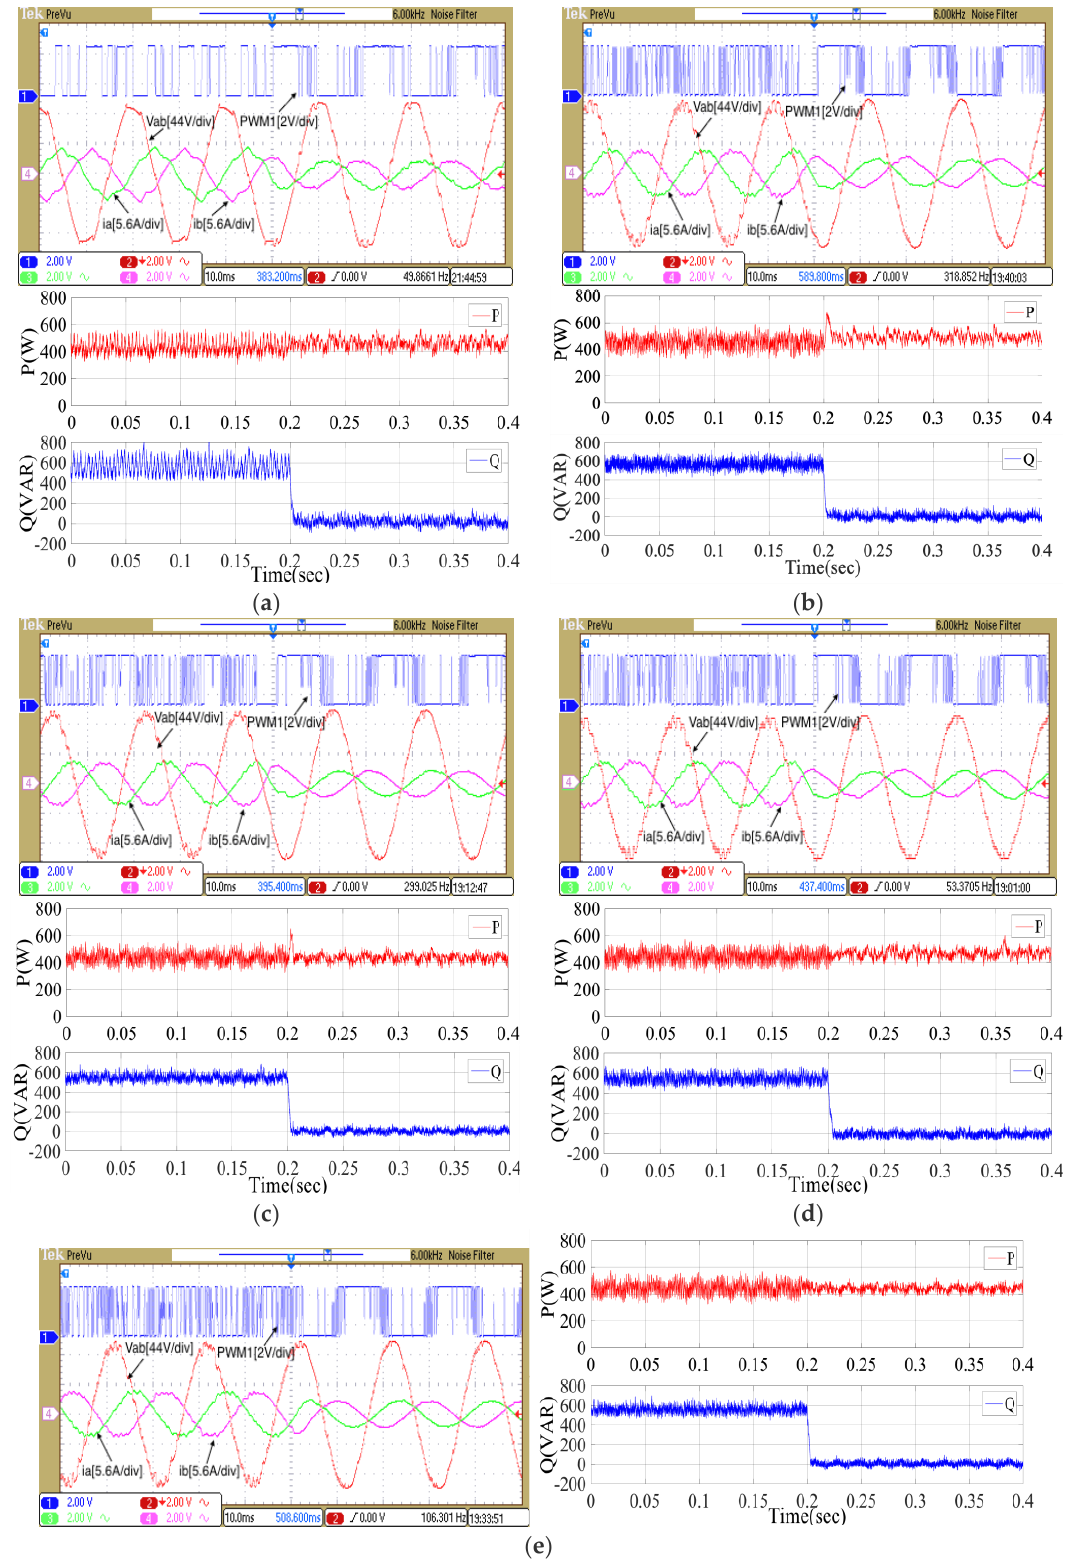
Figure 8. Experimental results when P = 450 W, Q changes from 550 Var to 0 Var. Top: PWM signal, V ab , i a and i b . Bottom: active and reactive power. ( a ) CDPC. ( b ) CMPC-I. ( c ) CMPC-II ( d ) MMPC-I. ( e ) MMPC-II.